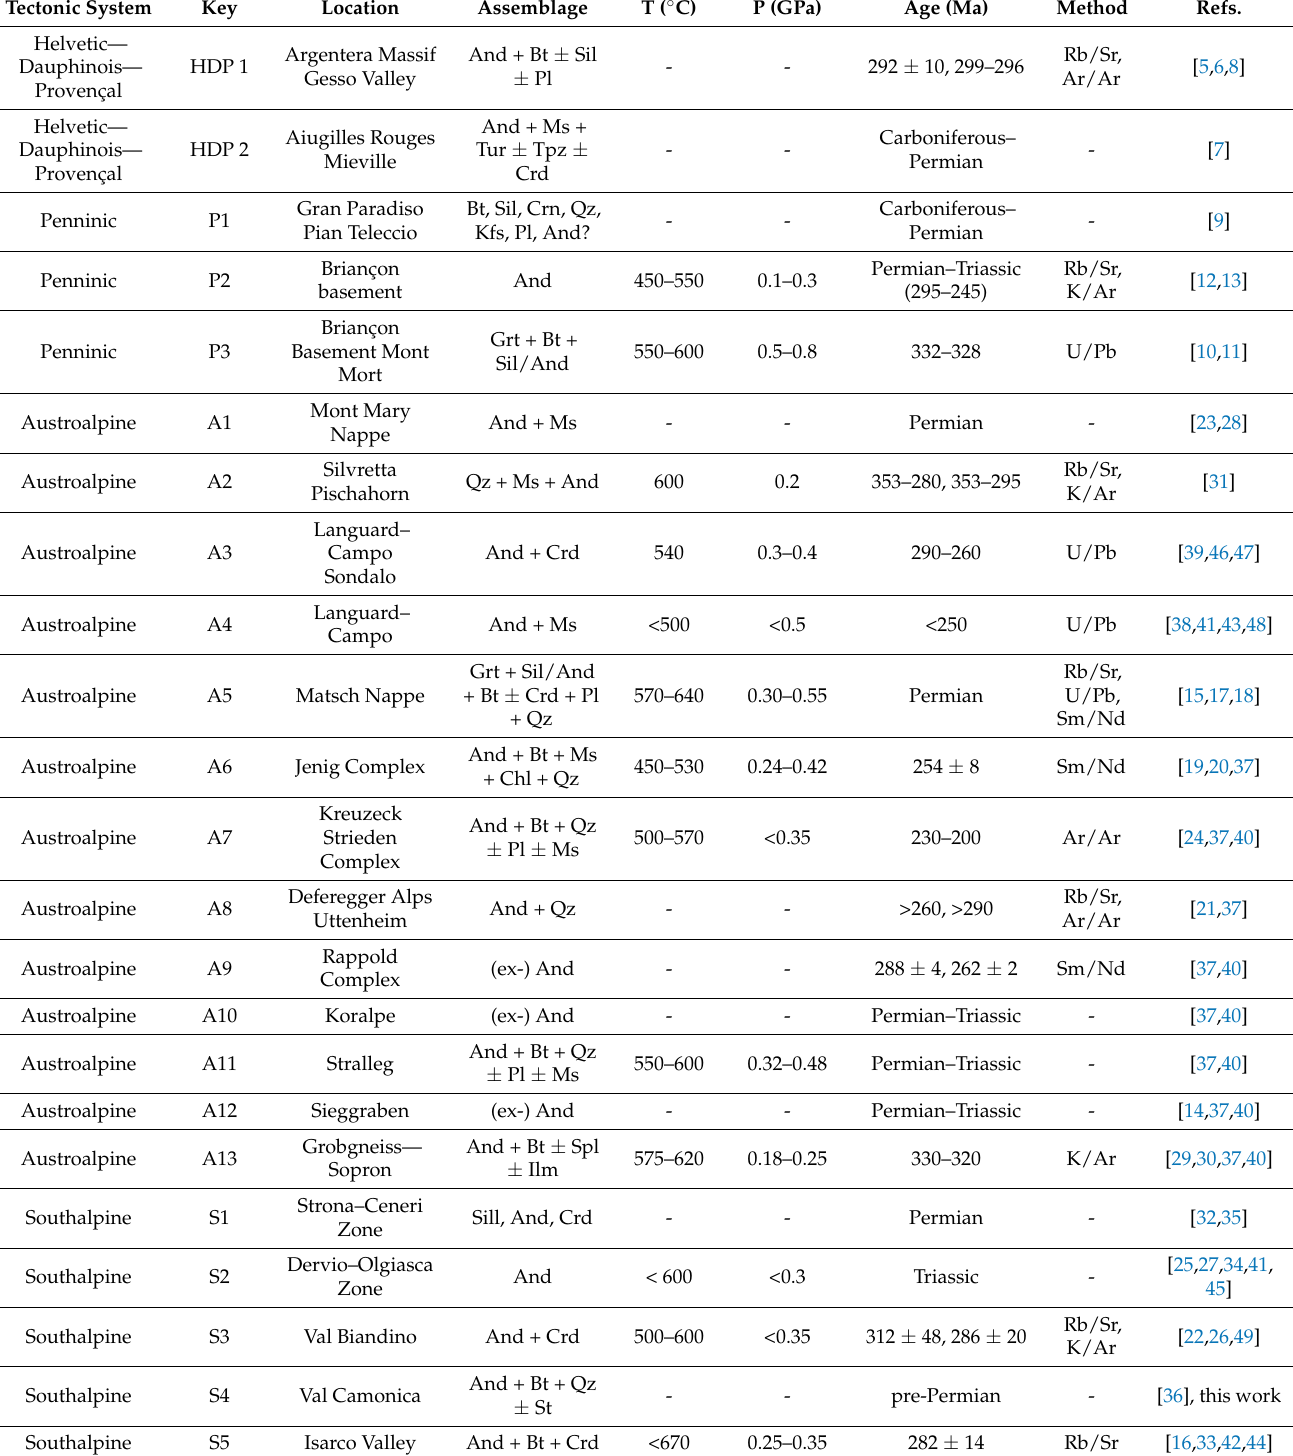
Table 1. Pre-Alpine andalusite-bearing assemblages in the continental crust of the Alps. Labels correspond to those of Figure 1. Mineral abbreviations follow [51]. When the radiometric method is not specified, the age is deduced from geological evidence or represents the average of results by different